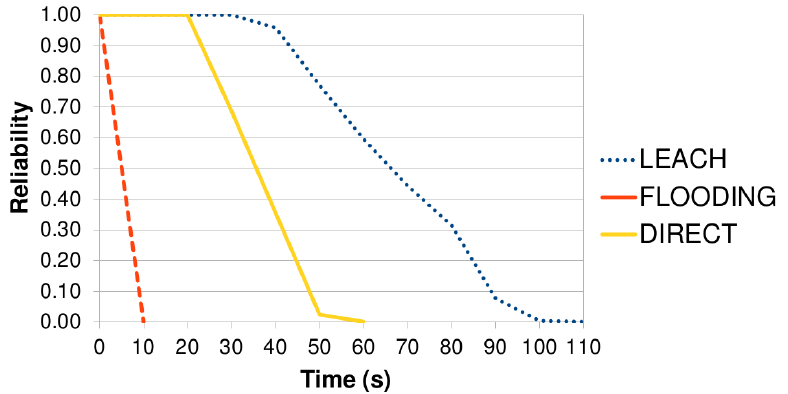
Figure 17. Results of the WSN